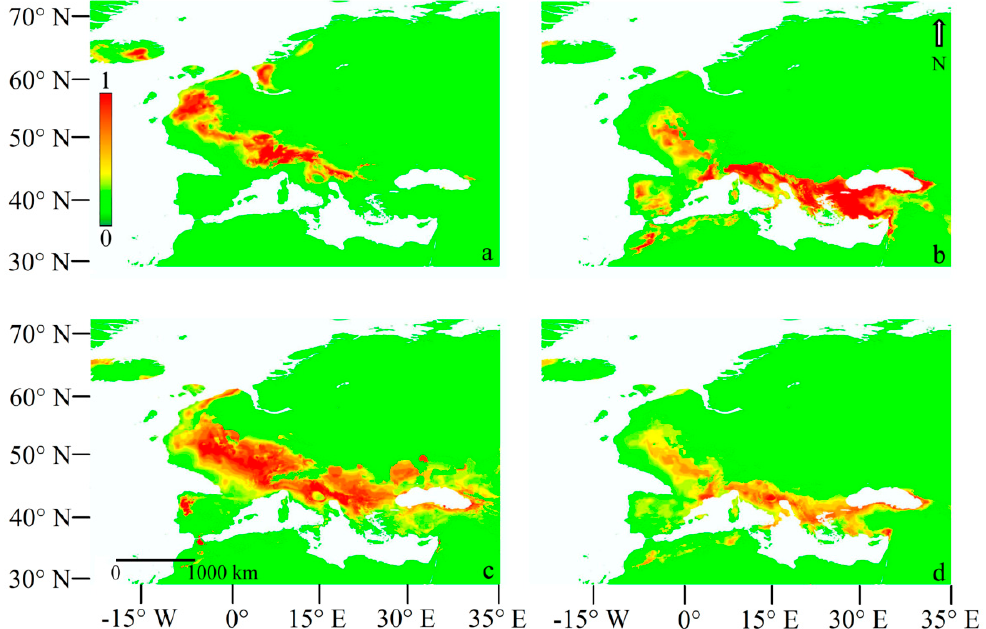
Figure 5. Ecological Niche Models for P. mugo / uncinata ( a ), P. nigra ( b ), P. sylvestris ( c ) and Q. pubescens ( d ) using the Last Glacial Maximum scenario. Scales show the probability of presence ranging from 0 to 1.